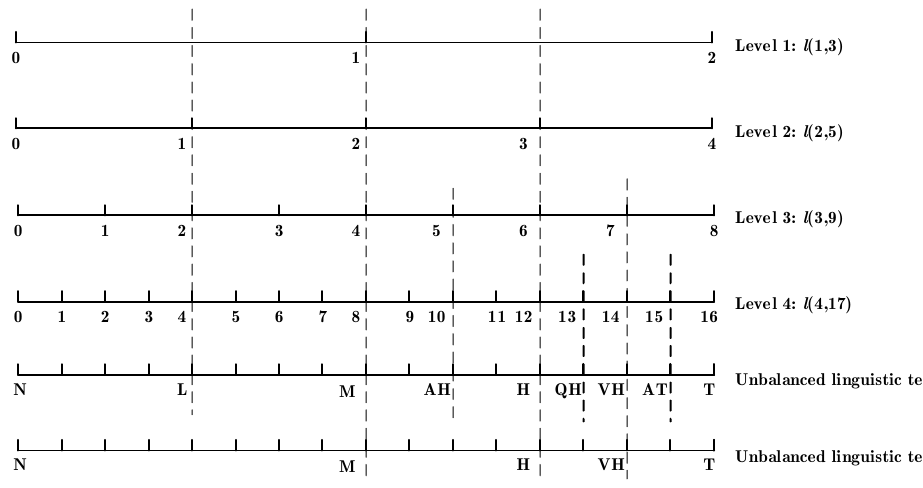
Figure 2. Unbalanced linguistic term sets ( S 1 and S 2 ) and their mapping in linguistic hierarchies. Table 2. The IVDHFUBL decision matrix